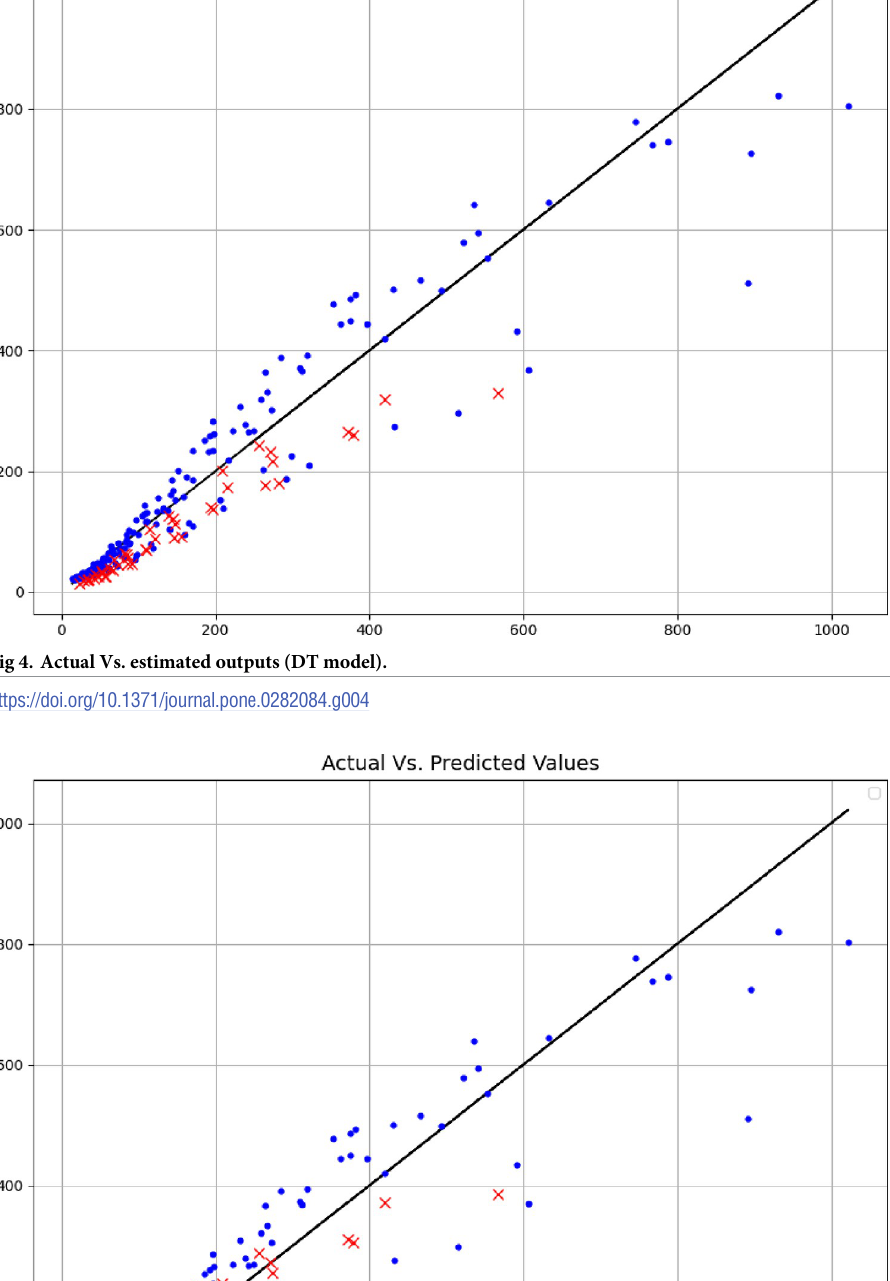
PLOS ONE | https://doi.org/10.1371/journal.pone.0282084 February 17,